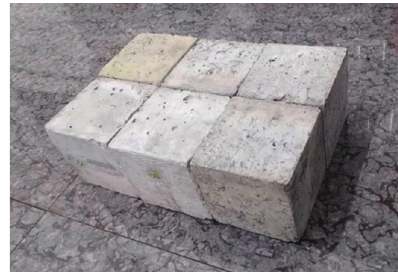
Figure 1: Processed concrete samples.